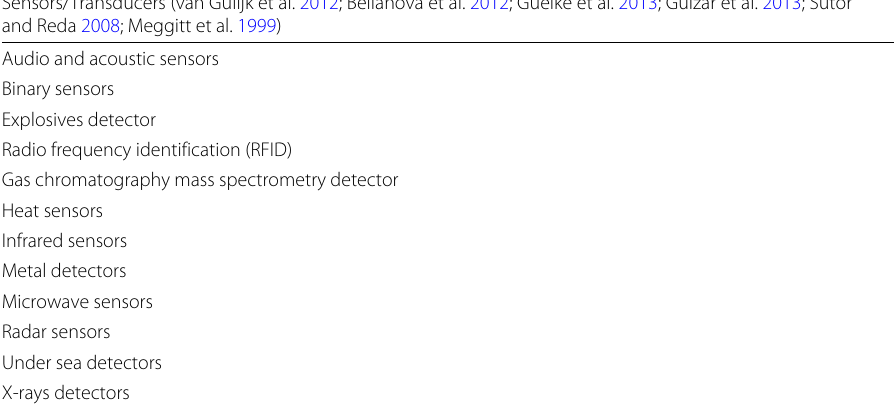
Table 2 List of